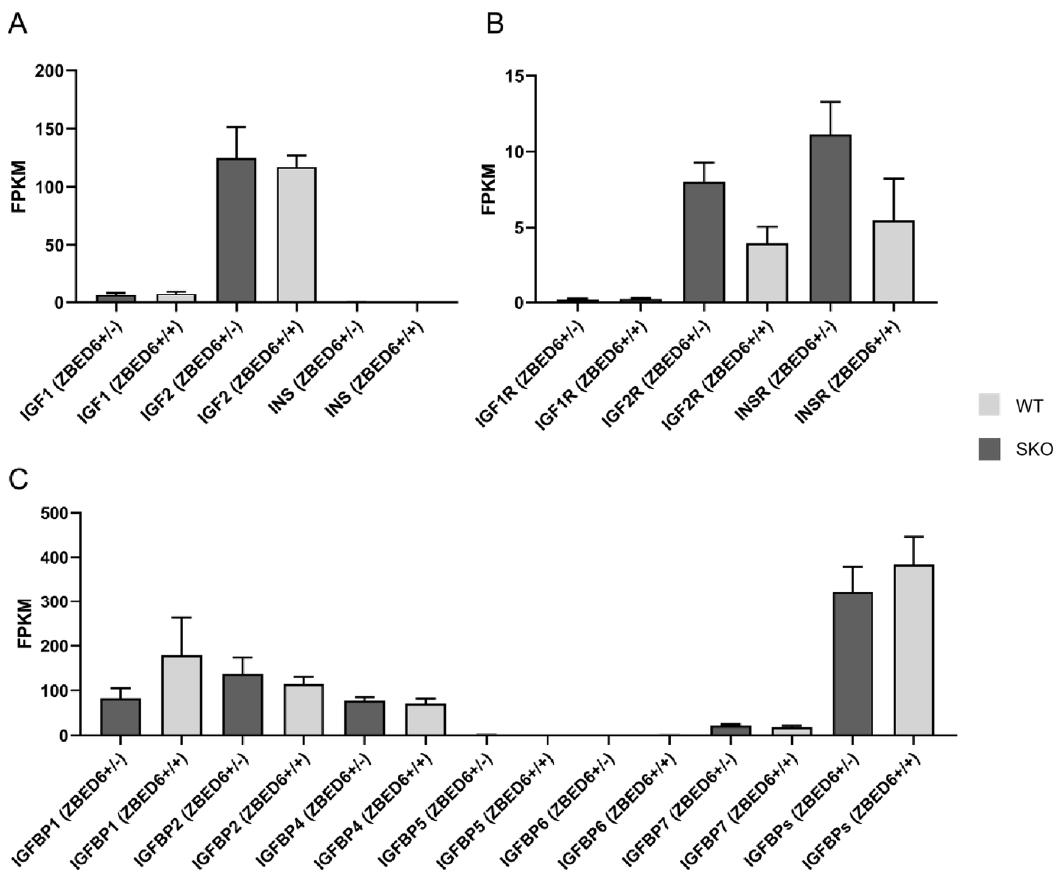
Figure 3. RNA-seq of IGF2 and related genes expression in ZBED6 -SKO and WT pig livers. ( A ) The expression (FPKM) of IGF1, IGF2 and INS in ZBED6 -SKO and WT pig livers. ( B ) The expression (FPKM) of IGF1R, IGF2R and INSR in ZBED6 -SKO and WT pig livers. ( C ) The expression (FPKM) of IGFBP family and the total expression (FPKM) of IGFBPs in ZBED6 -SKO and WT pig livers. Notes: SKO: one allele knockout; WT: wild type; FPKM: fragments per kilobase per million; IGF1-2: insulin-like growth factor 1-2; IGF1R: insulin like growth factor 1 receptor; IGF2R: insulin like growth factor 2 receptor; INS: insulin; INSR: insulin receptor; IGFBP1-7: insulin-like growth factor binding protein 1-7; (+/+): wild type; (+/-): single knock type.